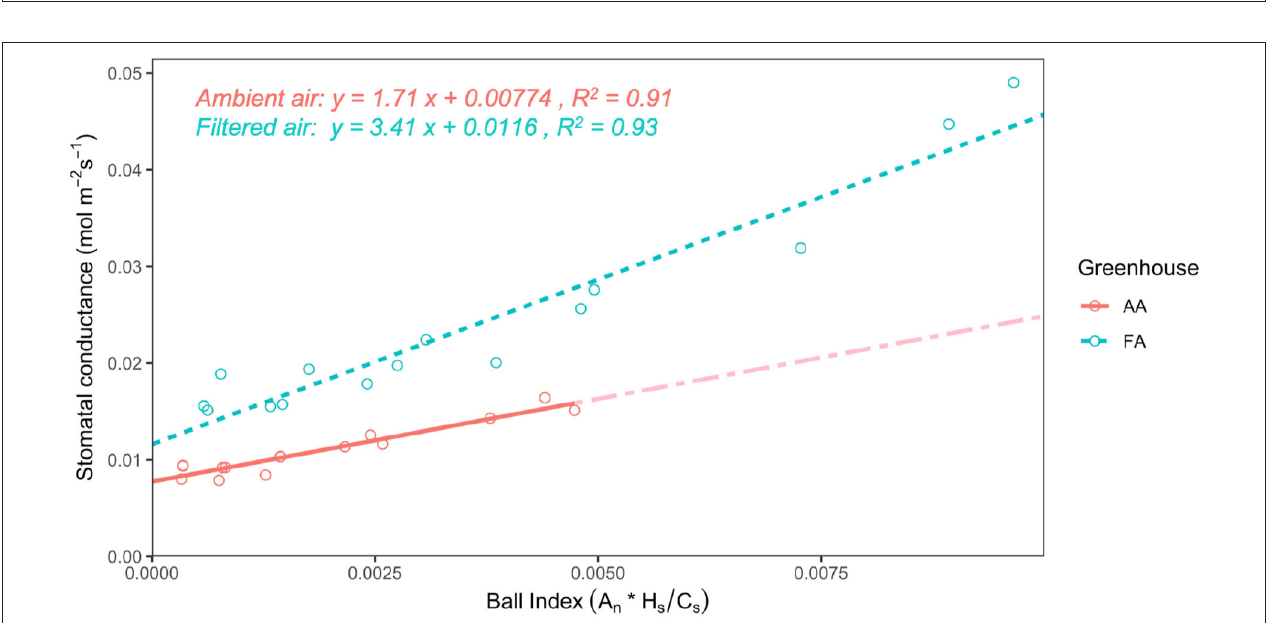
FIGURE 4 | Relationship of stomatal conductance with the Ball Index for leaves from greenhouse AA (ambient air) and greenhouse FA (filtered air). The linear regressions of the Ball-Berry model represent the means of linear functions fitted to data from individual leaves at all measured vapor pressure deficit (VPD) levels; the Ball Index is calculated with assimilation (A n ), relative humidity (H s ), and CO 2 concentration at the leaf surface (C s ). The solid line is AA, with a partially dash-dotted line showing the extension to the full range of the x-axis, based on predicted data points from the linear regression; and the dashed line is FA. A statistical analysis of the slope and intercept indicates a significant difference in the Ball-Berry model between leaves from AA and FA ( P < 0.005).